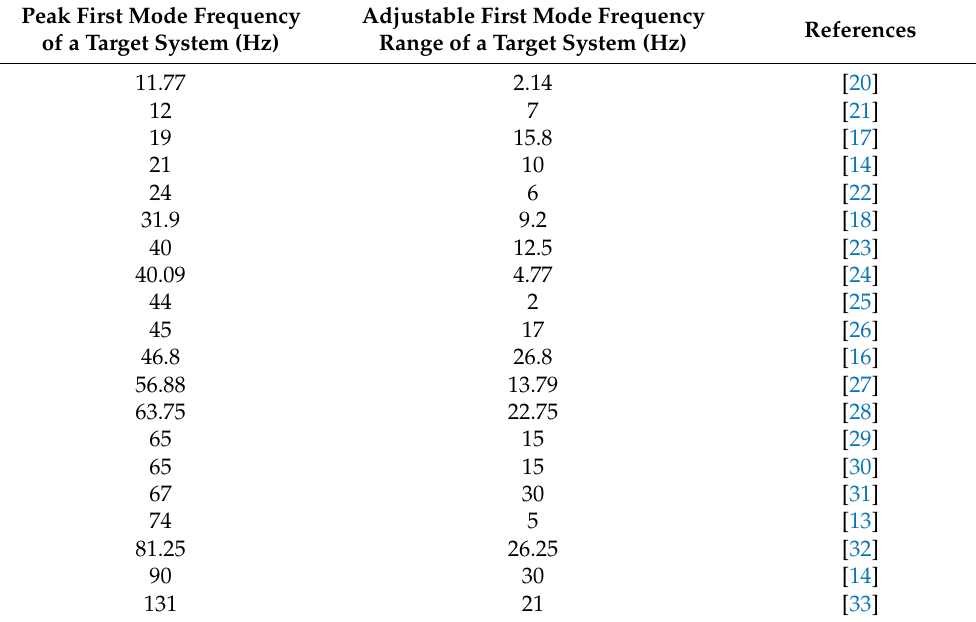
Table 1. Comparison on the peak first mode frequency and adjustable first mode frequency range of a target system in most reported studies on adaptive